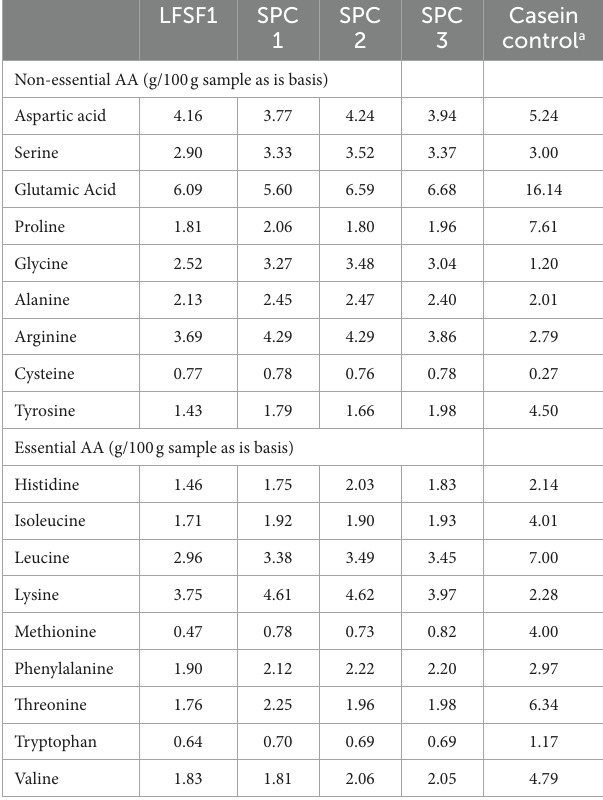
TABLE 4 Amino acid composition of LFSF1 and its SPC at the large-scale production